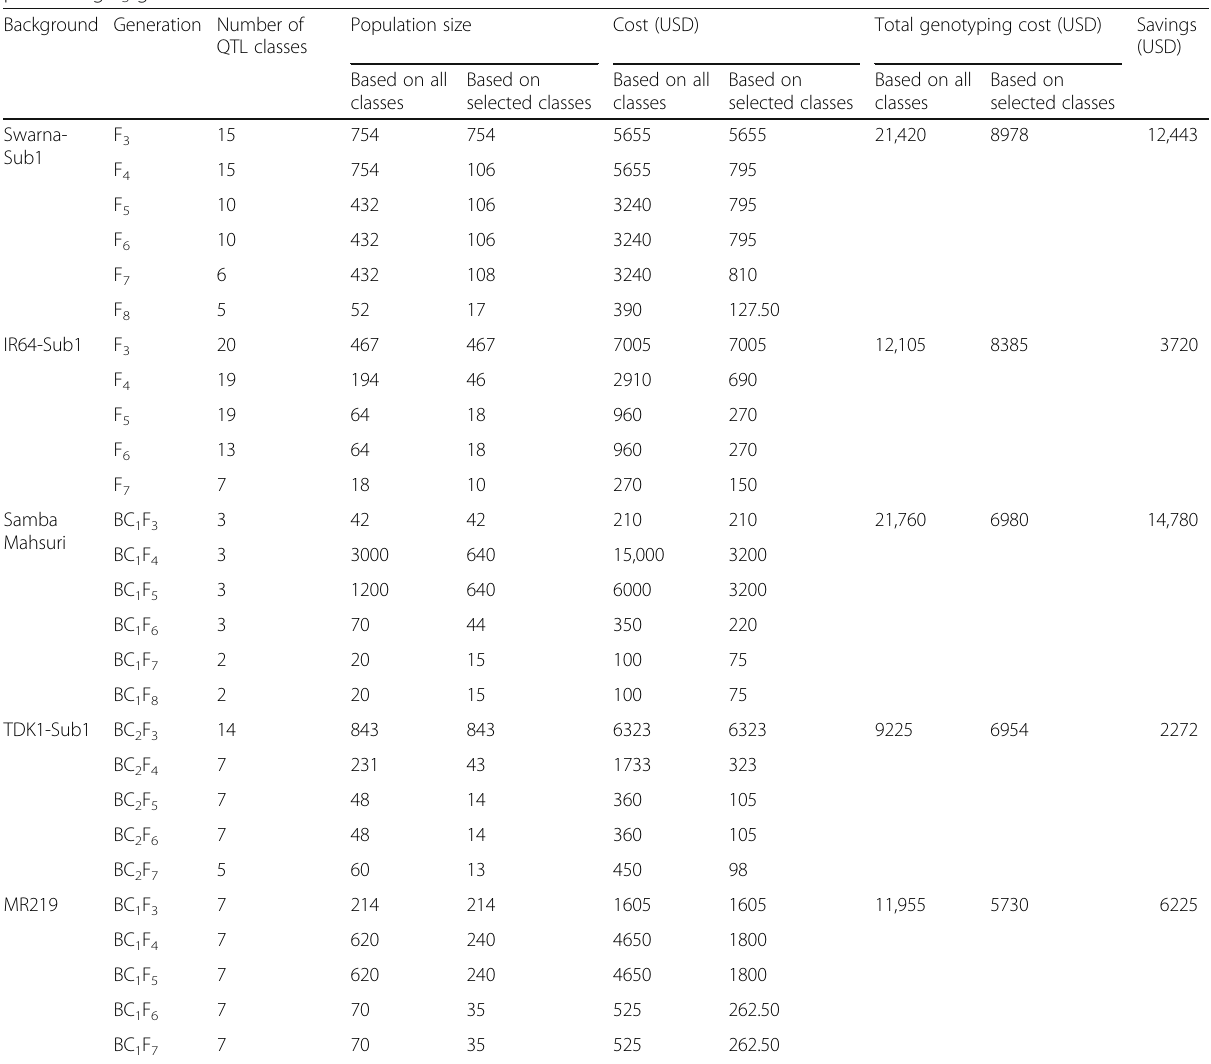
Table 6 Comparison of genotyping cost (USD) considering advancement of all QTL classes versus advancement of only higher performing F 3 generation QTL classes Background Generation Number of QTL